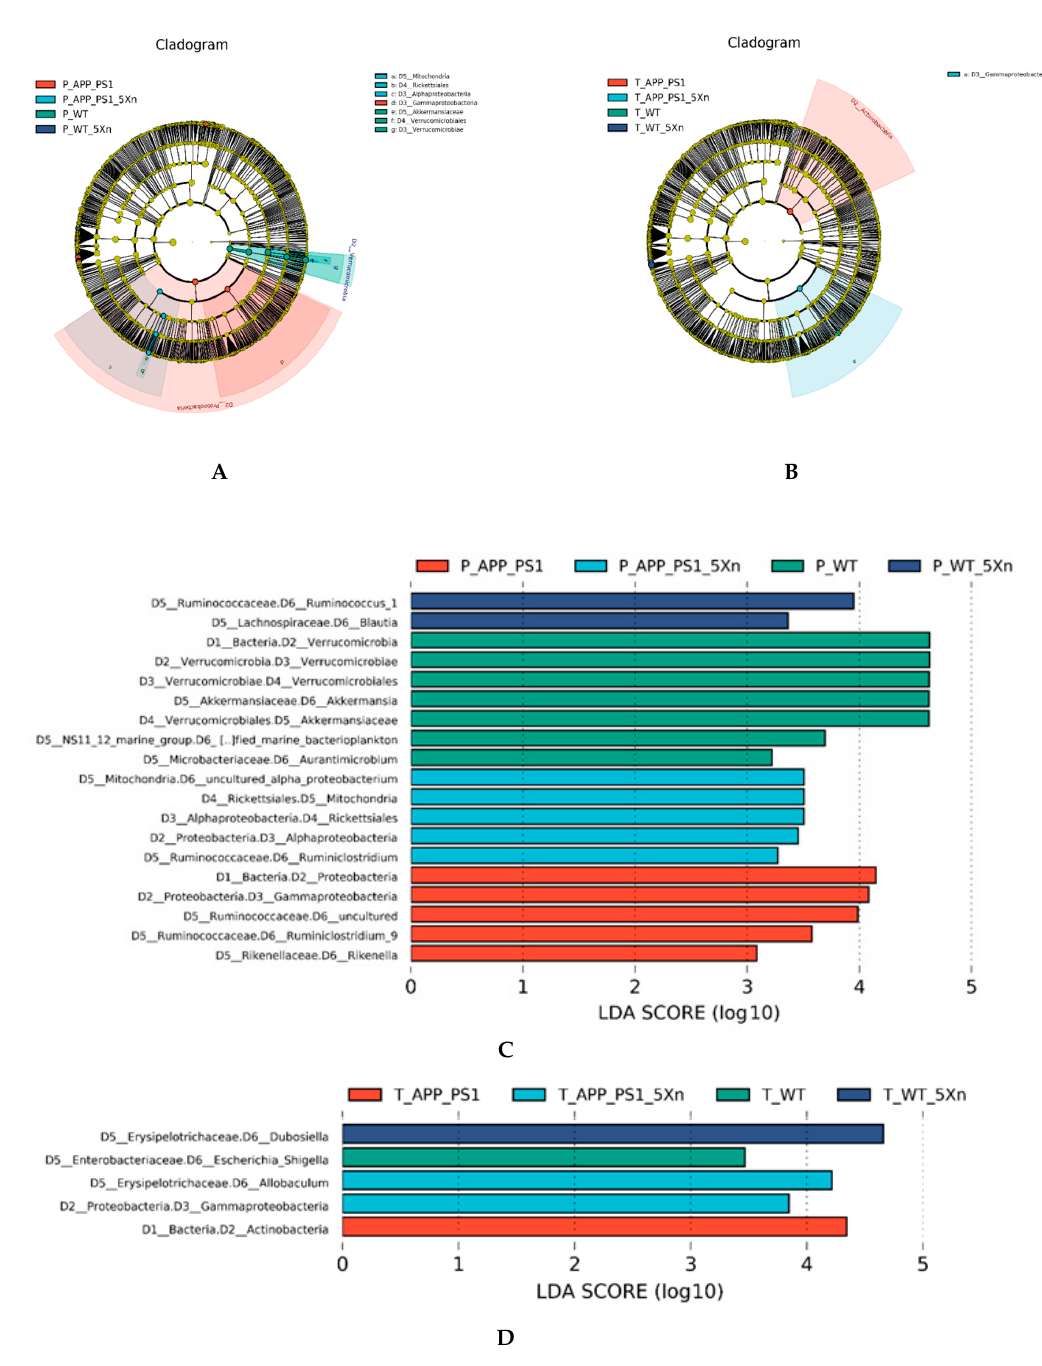
Figure 4. Differential species via LEfSe analysis in the prevention and therapy experiment of Xn. ( A , B ) Evolutionary cladogram of different species in the prevention and the therapy experiment, respectively. The circle radiating from the inside to the outside represents the level from the phylum to the species. Each small circle at different levels represents a category at that level, and the diameter of the small circle is proportional to the relative abundance. Species with no significant differences are uniformly colored yellow, and other different species are colored according to the grouping of the species. Different colors indicate different groups, and nodes of different colors indicate the microbiota play an important role in the group. ( C , D ) LDA score histogram of different species in the prevention and the therapy experiment, respectively. LDA score was used to assess the impact of significantly differential species. The larger the score, the bigger the impact. These pictures show different species with LDA score greater than 3.0. LDA, Line Discriminant